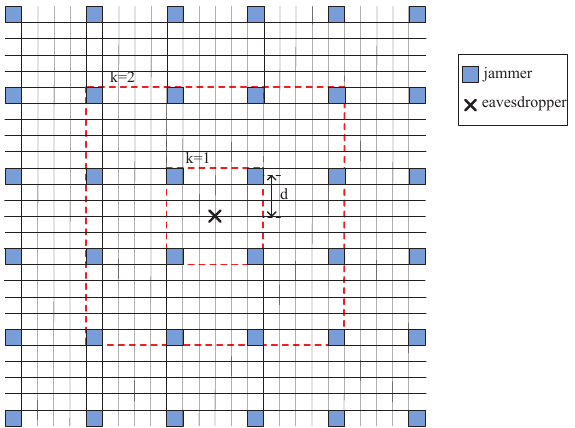
Figure 1. FJ-Reg Scheme: every jammer is placed at a gray square. Note that we only show a part of the whole network.